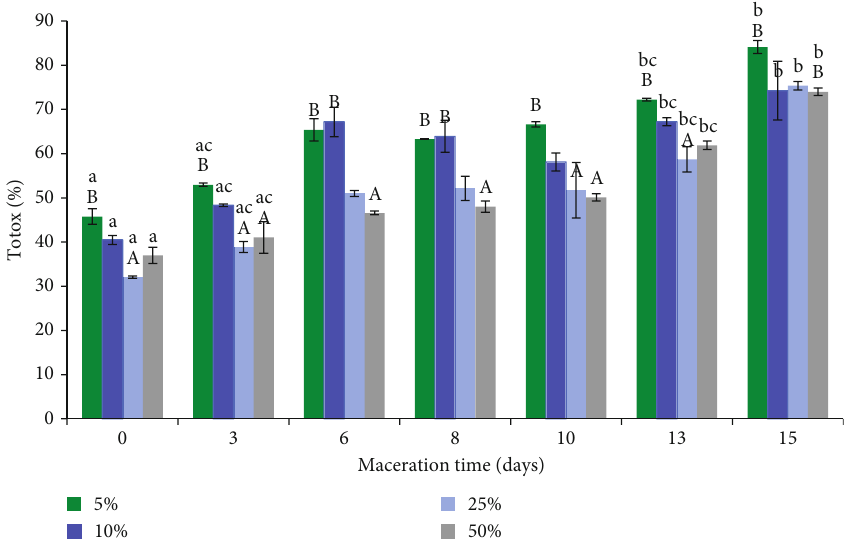
Figure 4: The e ff ect of the addition of di ff erent concentrations of sage macerate (5%M-50%M), applied after a di ff erent day of maceration, on CLO quality parameters, expressed as delta ( Δ ) of Totox, in the UV test (Values marked with the same lowercase letter a, ac, … , do not di ff er statistically signi fi cantly ( p < 0 : 05 ) within each macerate concentration, while the values marked with the same uppercase letter — A, AC — do not di ff er statistically signi fi cantly ( p < 0 : 05 ) on individual maceration days).